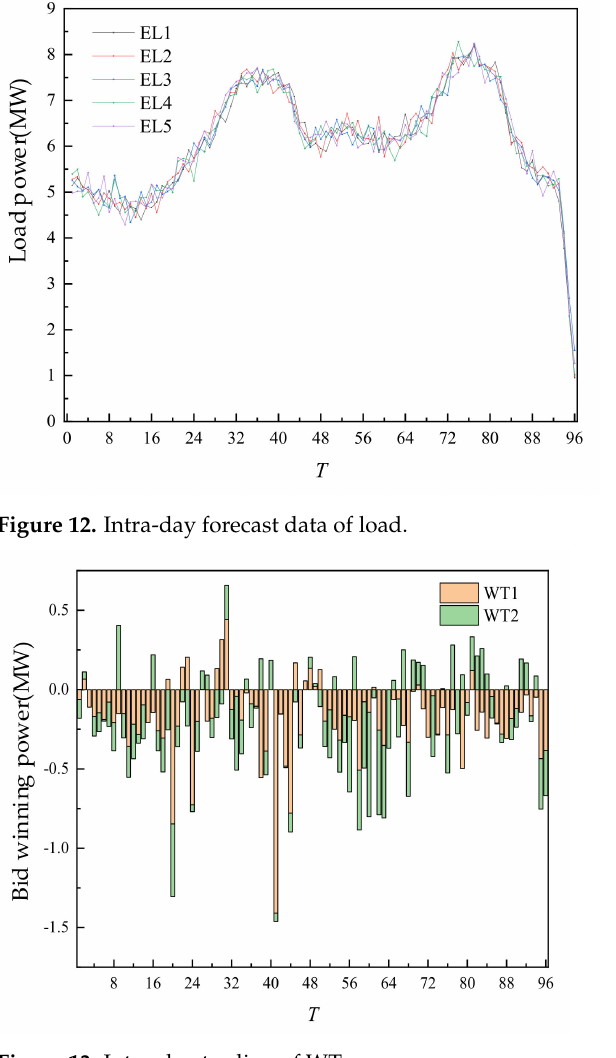
Figure 13. Intra-day trading of